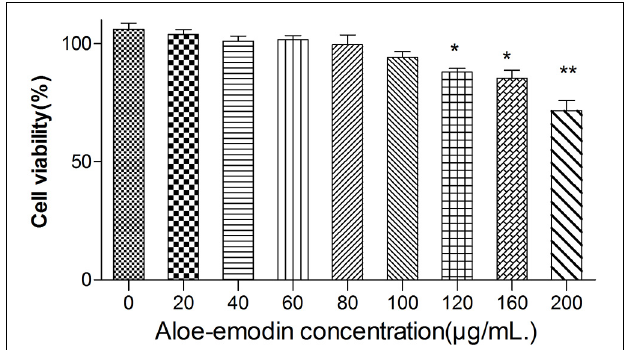
FIGURE 2 | Cytotoxicity of aloe-emodin as determined by the MTT method. Cytotoxicity is shown as the OD value of RAW 264.7 cells under aloe-emodin exposure. Aloe-emodin exhibited cytotoxicity in a dose-dependent manner. High doses ( > 100 µ g/mL) of aloe-emodin significantly decreased cellular viability, whereas low doses showed no cytotoxicity. Single asterisk (*) indicates P < 0.05, and double asterisks (**) indicate P < 0.01 vs. non-treatment group.